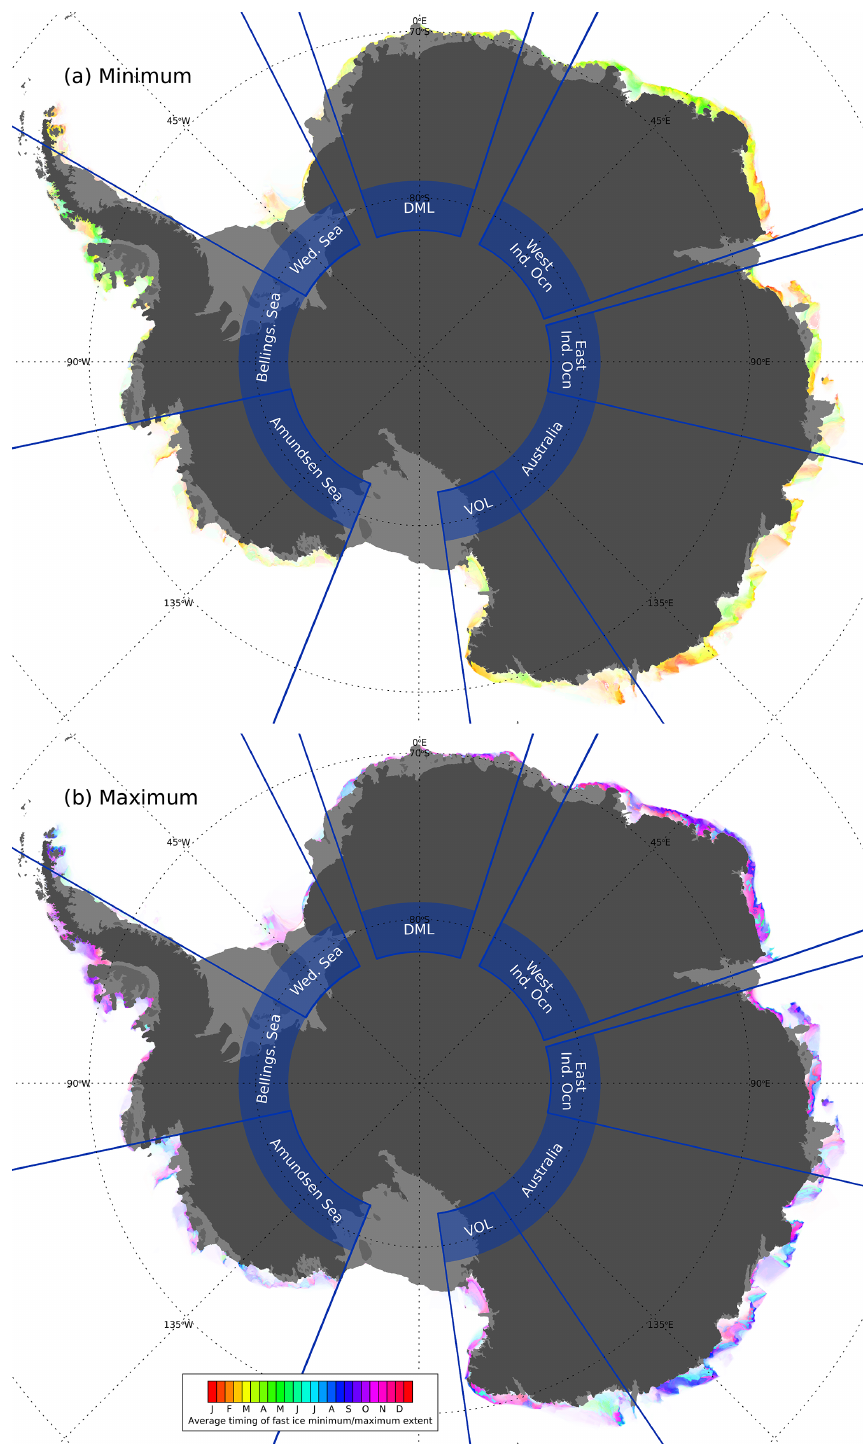
Figure 3. Per-pixel average timing of minimum (a) and maximum (b) fast-ice extent. For each pixel, colour saturation is weighted by annual cycle magnitude (i.e. pixels with persistent multi-year fast ice or no fast ice are transparent).